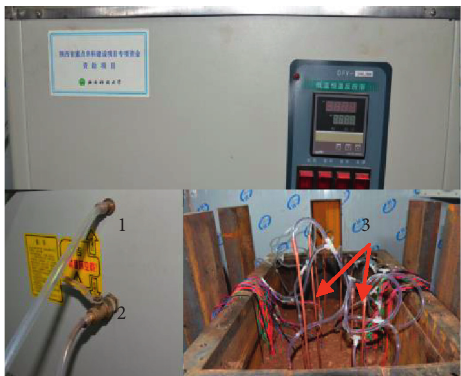
Figure 3: Freezing system.1: cold-liquid inlet, 2: cold-liquid outlet, and 3: frozen